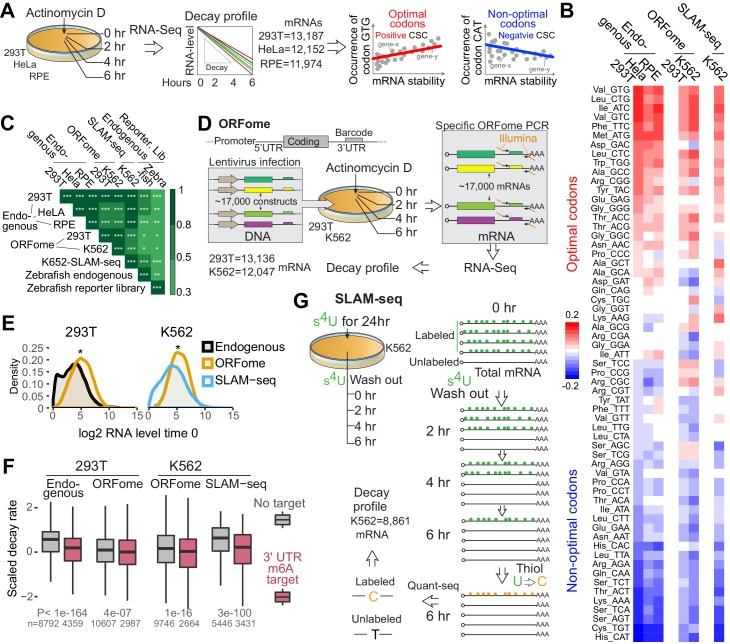
Human mRNA decay correlate with codon composition in human lines.(A) Scheme of the mRNA endogenous decay profiles approach in 293T, HeLa and RPE cells. RNA-seq was performed at different time after blocking transcription by Actinomycin D treatment. The codon stabilization coefficient (CSC) is calculated as the Pearson correlation coefficient between the occurrence of each codon and mRNA stability. (B) Heatmap showing the codon stability coefficient (CSC) calculated in the indicated cell lines and approaches used to measure mRNA stability. (C) Heatmap showing the Spearman rank correlations between CSC calculated in different human cells lines and using different methods to calculate mRNA stability. CSC calculated in zebrafish embryos with two independent methods were included (Bazzini et al., 2016). *p<0.05, **p<0.01 and ***p<1e-16. (D) Diagram illustrating the ORFome decay profiles approach. Cells were infected with lentivirus carrying approximately 17,000 expression vectors containing different coding sequences but sharing the same promoter, 5’ and 3’UTRs. Each vector contains a 20-nucleotide long unique barcode in the 3’UTR. Infected cells were selected by puromycin treatments. RNA was isolated at different time after blocking transcription by Actinomycin D. Specific RNA-seq libraries were generated amplifying the shared sequences surrounding the barcodes and mRNA ORFome decay was calculated based on the sequences. (E) Density distribution of the mRNA level in 293T or K562 cells using the indicated techniques. Two-sample Kolmogorov-Smirnov test is used, *p<1e-50. (F) Boxplot showing the scaled mRNA decay of previously defined m6A targets mRNAs and as control, mRNAs that were not defined at m6A targets in the indicated cell line and using the indicated method to calculate decay. A linear model is used to estimate the difference. Number of genes (n) and p value KS test indicated. (G) Schematic representation of the SLAM-seq. Cells were fed with s4U every 3 hr for 24hs hours. Orthogonal-chemistry-based RNA sequencing was preformed after washing out the s4U. Decay profiles were calculated based on the chase of the label/unlabeled mRNAs (T to C conversion).
10.7554/eLife.45396.005Figure 1—source data 1.mRNA stability profiles used in Figure 1.

10.7554/eLife.45396.006Figure 1—source data 2.CSC scores from Figure 1B.